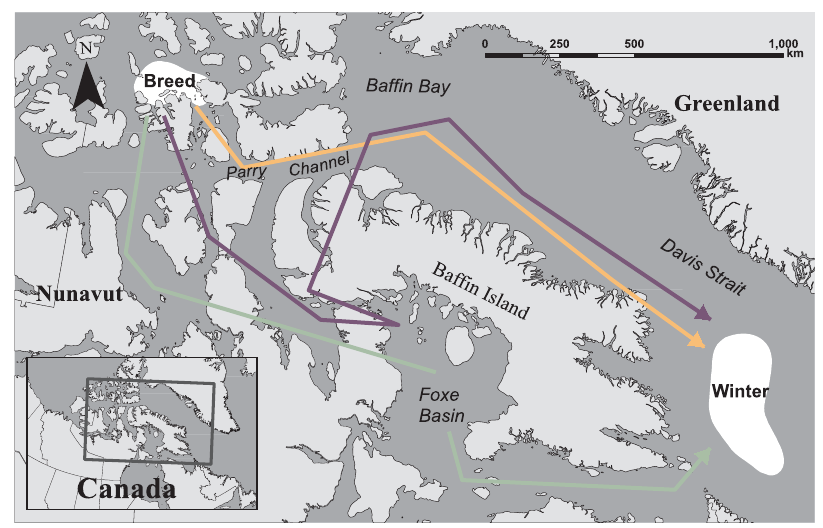
Fig. 2. General direction of post-breeding migratory ivory gulls. a) Nine bird-years traveled south via Davis Strait (orange arrow); b) three bird-years traveled south via Foxe Basin Strait during and (green); and c) two bird-years traveled south via Foxe Basin, cutting north across Baffin Island and south through Davis Strait (purple) over the study period (July 2010- July